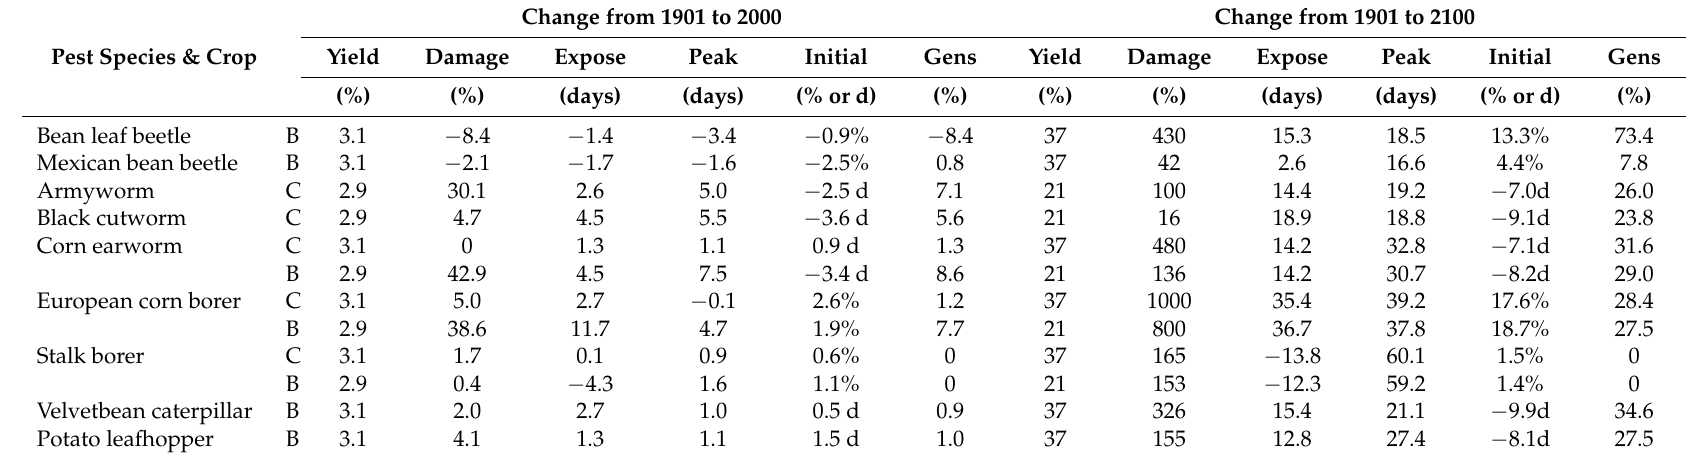
Table 2. Changes in predicted outcomes and insect life history